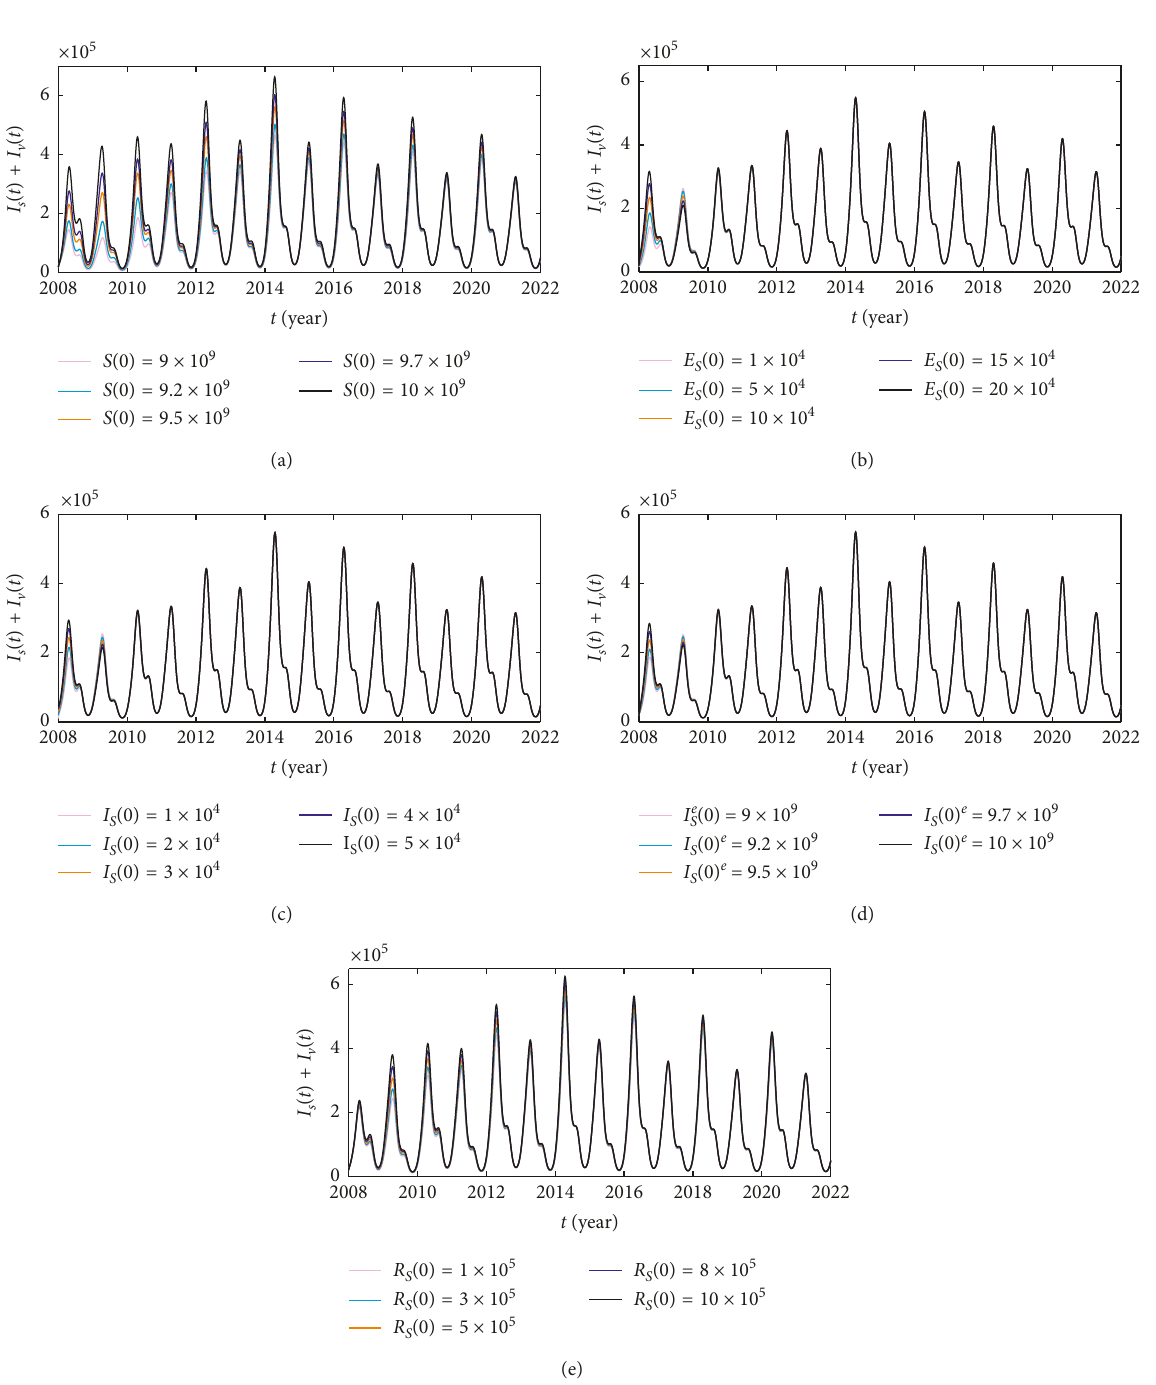
( t ) + I ( t ) : (a) different values of S ( 0 ) ; (b) different s v